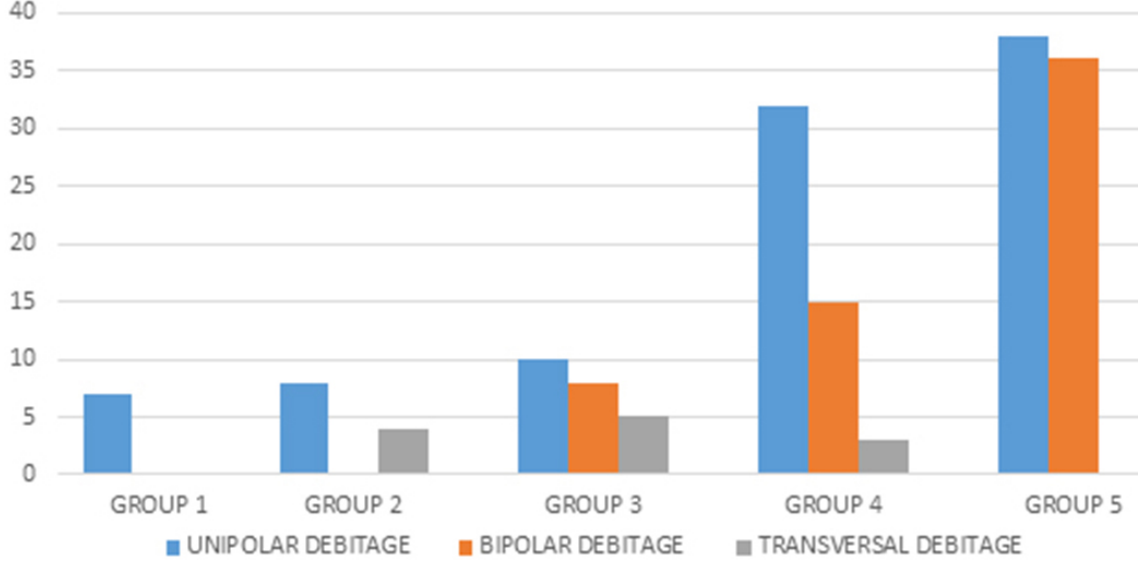
Figure 19. Technological analysis of laminar flakes and